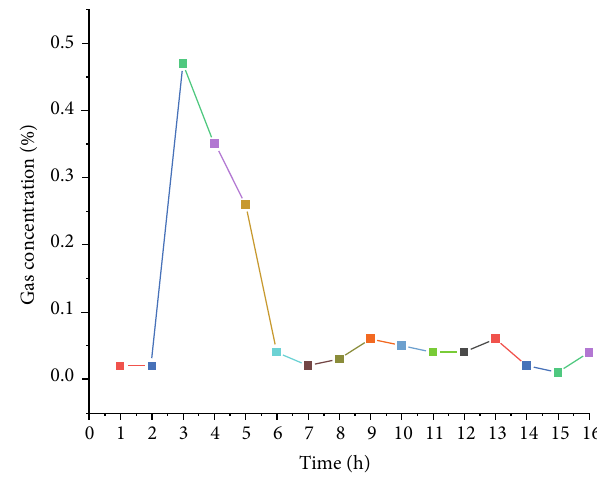
Figure 3: Gas concentration over time